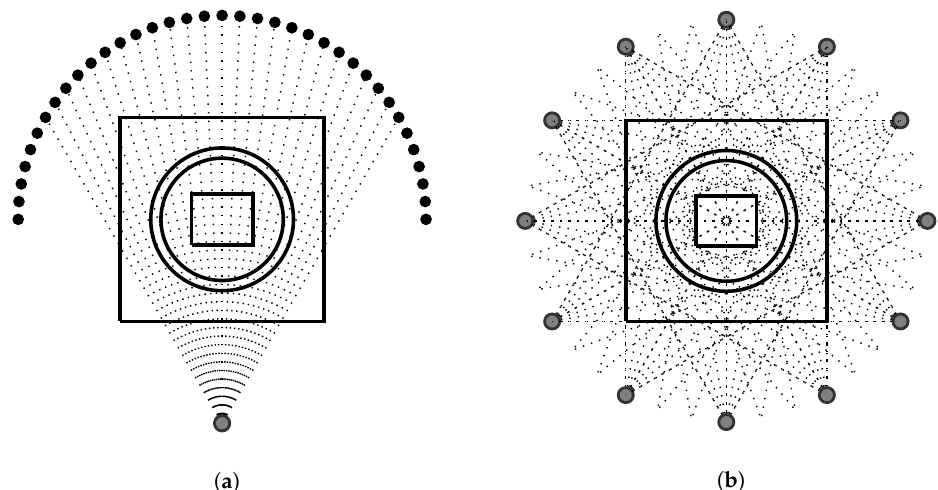
Figure 6. ( a ) Scanning architecture for a single source, the radius of the circle passing through detectors and source is set to 1.5m. ( b ) A depiction of the sampling scheme with fan-beam geometry, the source is rotated around the object and acquires data from different